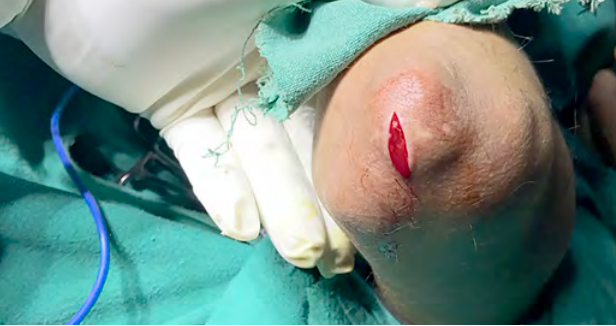
Fig 5 : Incision for insertion of rush pin for ulna